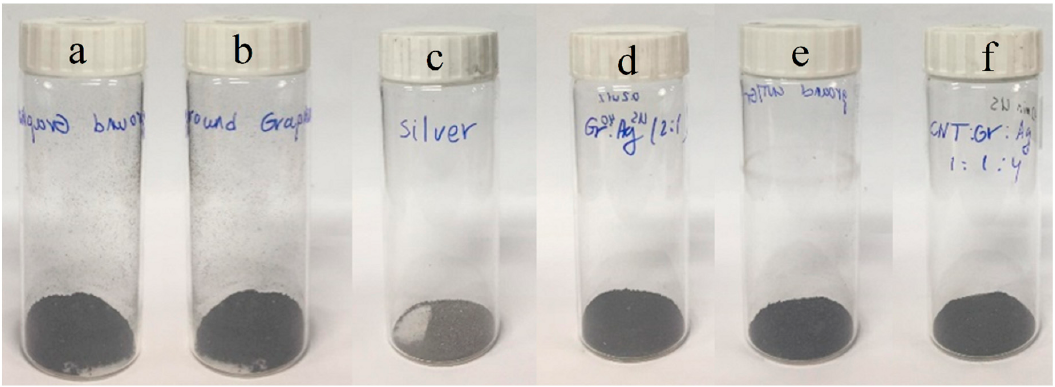
Figure 3. Photo of the dried nanoparticles. ( a )-MWCNT, ( b )-Gr, ( c )-Ag, ( d )-Gr/Ag, ( e )-MWCNT/Ag, ( f )-MWCNT/Gr/Ag.